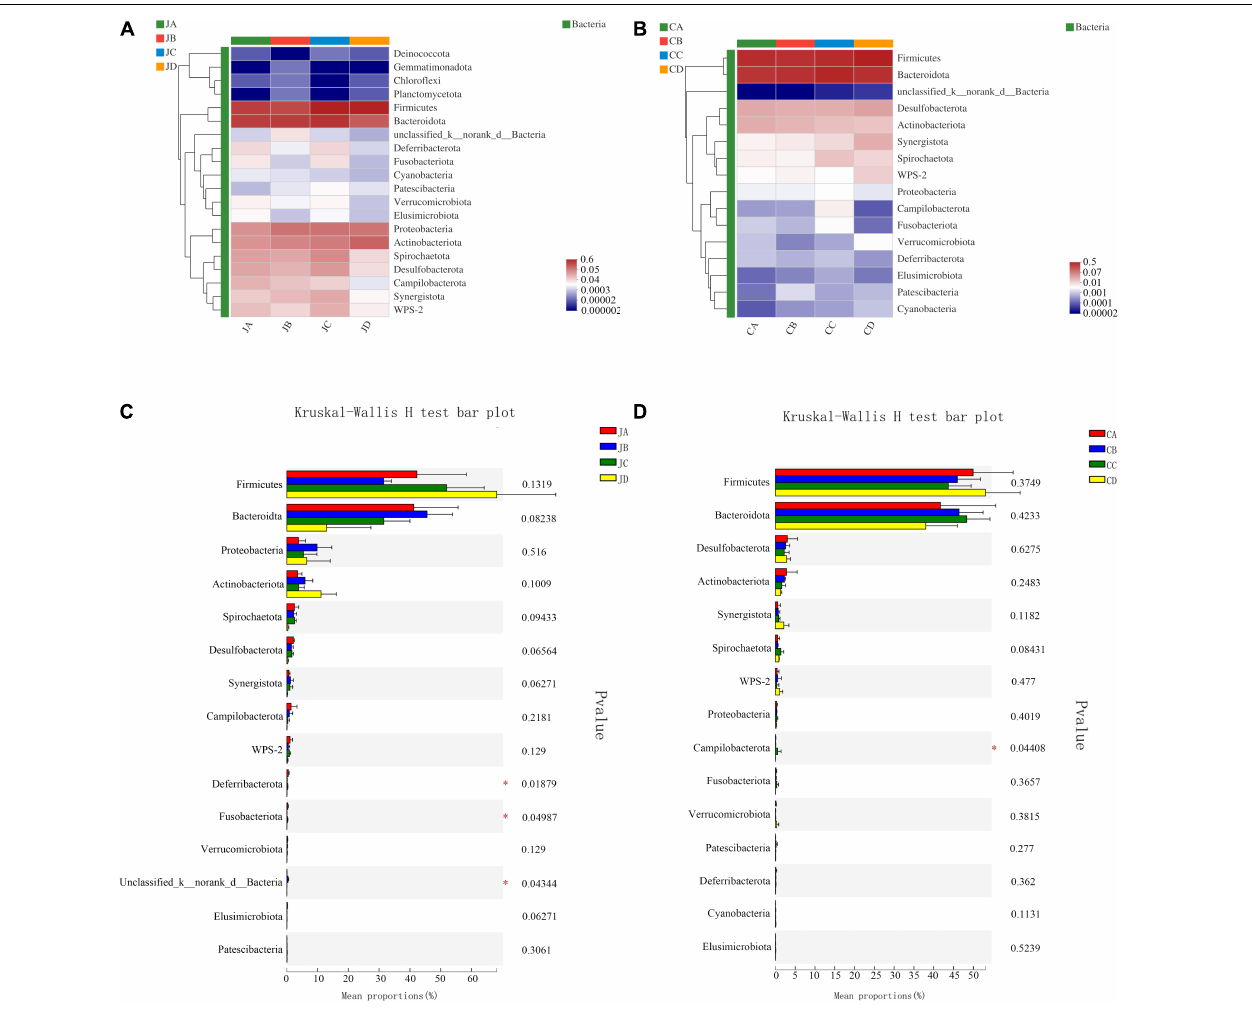
FIGURE 4 | Heatmap chart of top 20 phyla in different intestinal segments ( A : jejunum; B : cecum) and comparison of differences between groups of top 20 phyla ( C : jejunum; D : cecum). One-way analysis of variance, JA, jejunum of 0% HILM; JB, jejunum of 1% HILM; JC, jejunum of 3% HILM; JD, jejunum of 5% HILM; CA, cecum of 0% HILM; CB, cecum of 1% HILM; CC, cecum of 3% HILM; CD, cecum of 5%